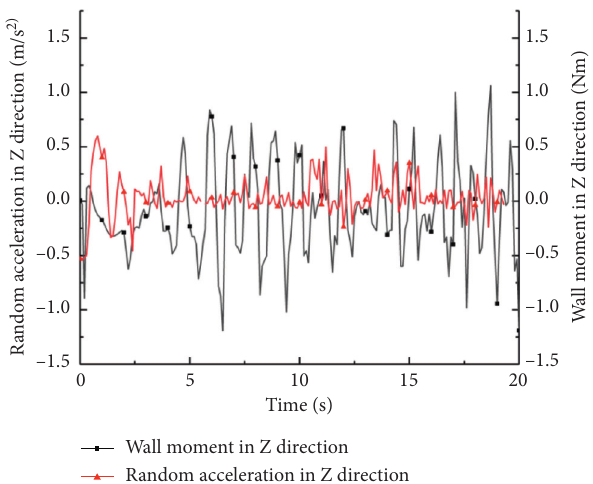
Figure 8: Relationship between stochastic acceleration and impact moment.